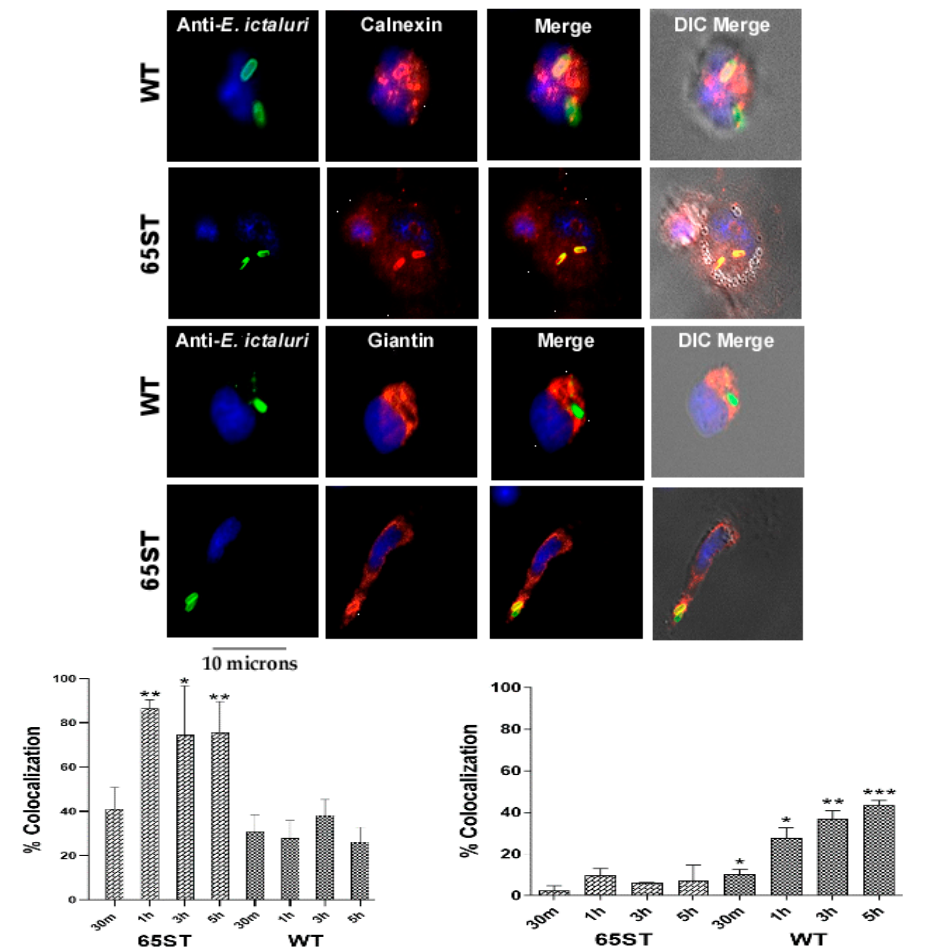
Figure 2. Immunofluorescence micrographs showing that co-localization of the endoplasmic reticulum marker calnexin (red) was significantly greater for ECV in 65ST from 1 to 5 h post-infection than for the WT, while co-localization of the Golgi marker giantin (red) was significantly greater for the WT ECV than for 65ST from 30 min to 5 h PI. The WT and 65 ST strains of E. ictaluri stain green in the ECV and the host cell nucleus stains blue. The host cell is visible in DIC in the merged image. The graphs show the percentage of the ECVs that co-localized with the given marker over time. Statistical significances over time were determined using one-tailed unpaired T-tests for each time period. Data presented as the mean of three sets of 100 cells counted. Asterisks indicate significant di ff erent di ff erences of the WT compared to the T3SS mutant 65ST (* = p ≤ 0.1, ** = p ≤ 0.01, *** = p ≤ 0.001). Early after invasion, for both WT and 65ST E. ictaluri , the autophagosome marker LC3 was recruited to the ECV of both strains, with 20% of WT and 30% of 65ST sequestered in LC3 positive autophagosomes at 30 min post-infection (Figure 3A). The percentage of WT bacteria located in autophagosomes subsequently decreased to less than 10% at 5 h PI. In contrast, 30% of the ECV in cells infected with 65ST were LC3 positive, which increased significantly to around 60% at 1, 3, and 5 h post-infection (Figure 3A). Immunofluorescent data were confirmed by Western blotting (Figure 3B,C), which also demonstrated significantly greater induction of the membrane-localized, lapidated form, LC3-II, in HKDM infected with 65ST than in non-infected HKDM or macrophages infected with WT (Figure 3B,C). This indicates that lipidation of LC3 to produce the autophagy indicator protein LC3-II occurred in 65ST-infected HKDM but not in WT-infected